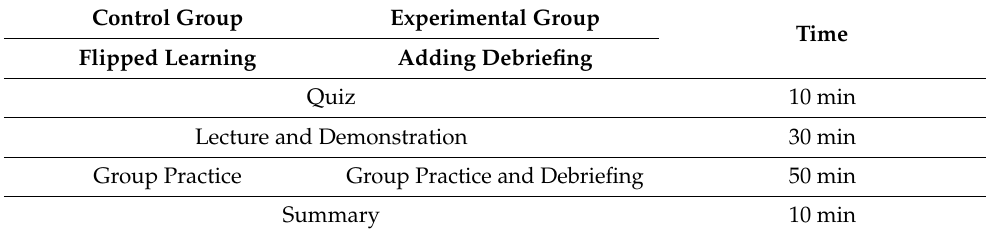
Table 1. Class time for the experimental and control